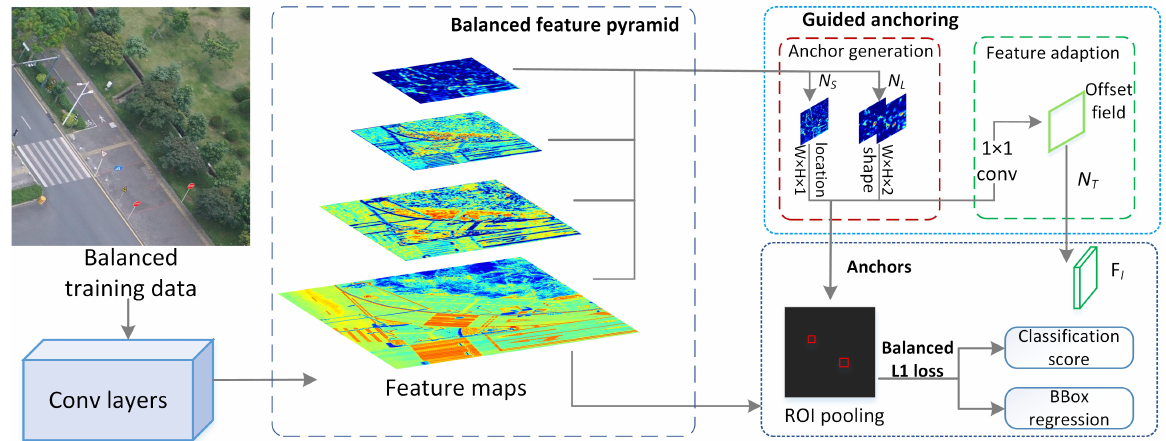
Figure 3. The end-to-end balance-learning framework for small object detection takes advantage of the region-based CNN and a data synthesis strategy.